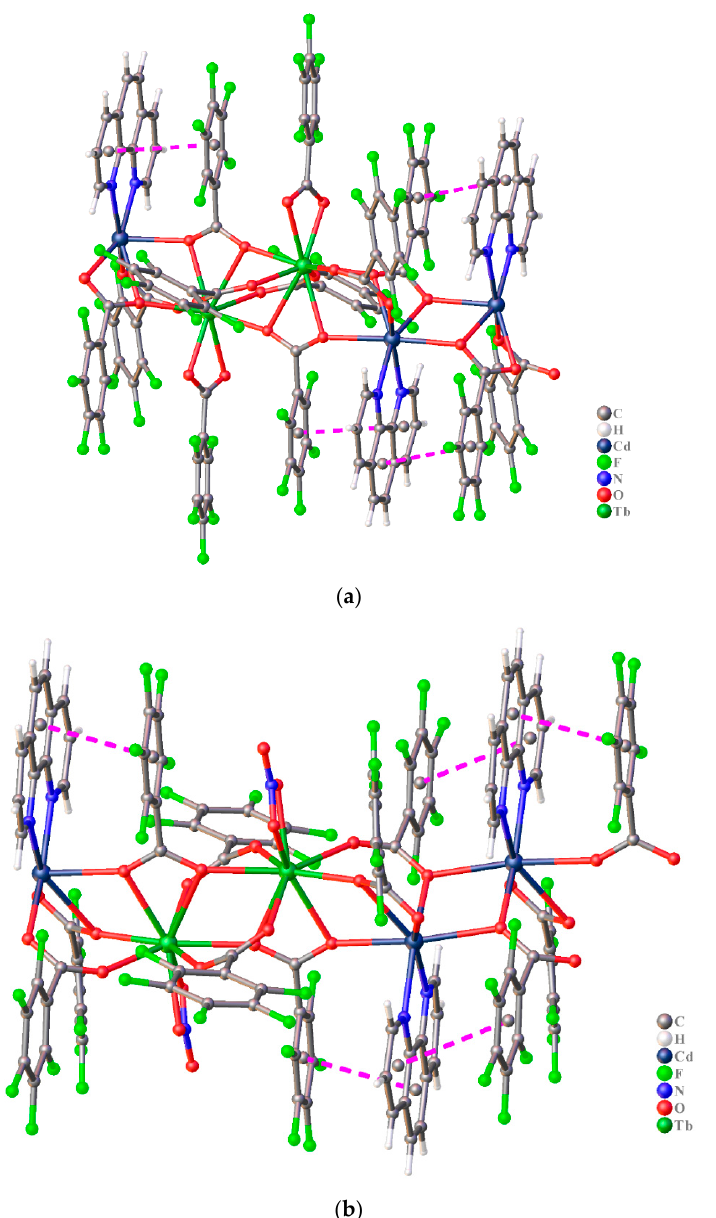
Figure 4. Structure of chains of polymer compounds 3 ( a ) and 4 ( b ) in crystals. The dotted line shows π ··· π interactions. Solvate molecules are not shown.